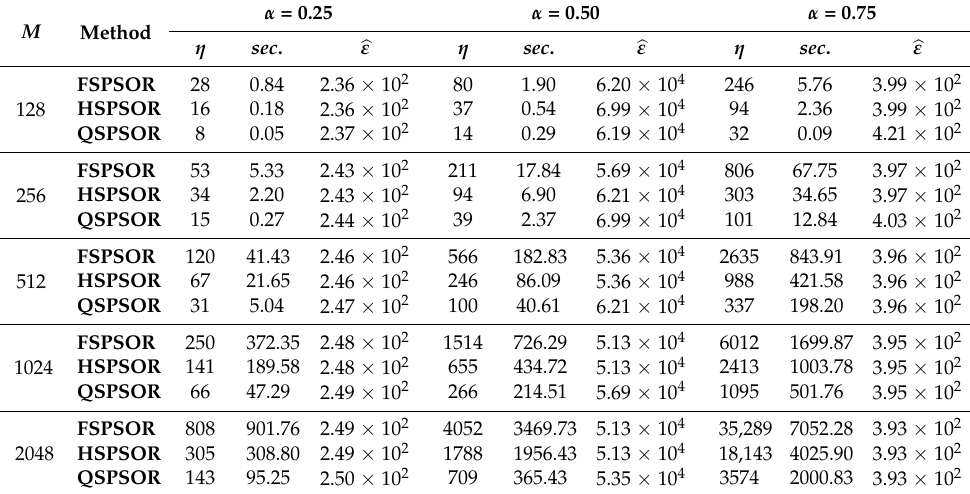
Table 2. Comparison between FSPSOR, HSPSOR, and QSPSOR in solving Example 1.